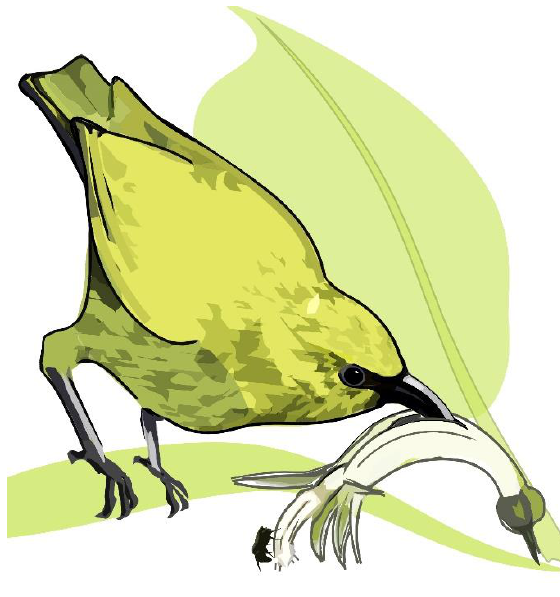
Figure 1. Illustration of a Delissea waianaeensis flower with nectar larceny by O ʻ ahu ʻ amakihi ( Chlorodrepanis flava ) and contacting pollen by yellow-faced bees ( Hylaeus sp . ).